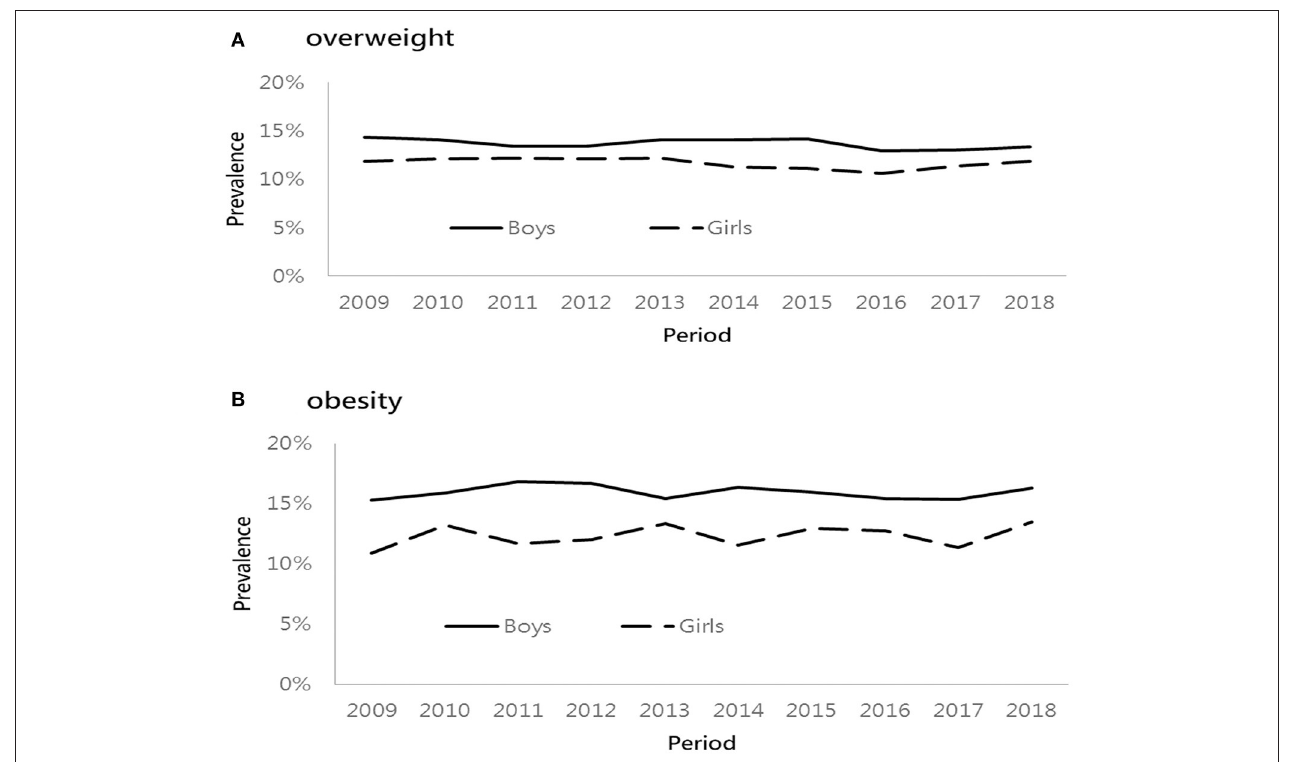
FIGURE 2 | Sex-specific prevalence of overweight and obese from 2009 to 2018. (A) overweight and (B) obesity.